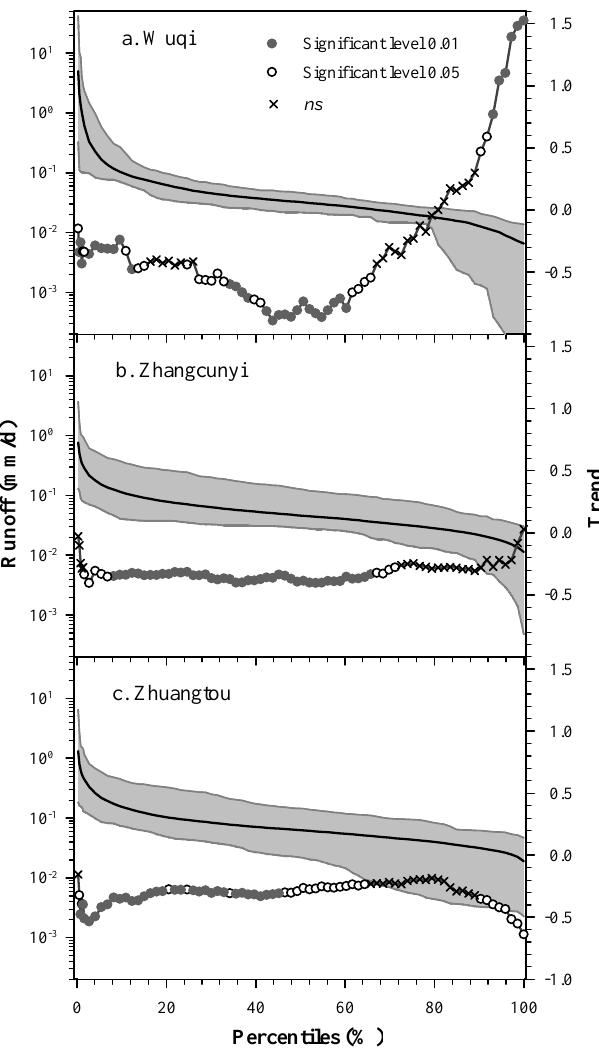
Figure 4. Trends, statistically significant levels, and ranges of daily streamflow series over the past six decades at the ( a ) Wuqi; ( b ) Zhangcunyi; and ( c ) Zhuangtou stations. The solid line represents the means of all daily streamflow series, the upper boundary of the gray strip represents the maximum of all daily series, and the lower boundary represents the minimum of all daily series. Table 5. Mean annual runoff variation ( ∆ Q t ˝ t ) and relative high ( Q 5 ), median ( Q 50 ), and low flow ( Q 95 ) changes during for the PII and